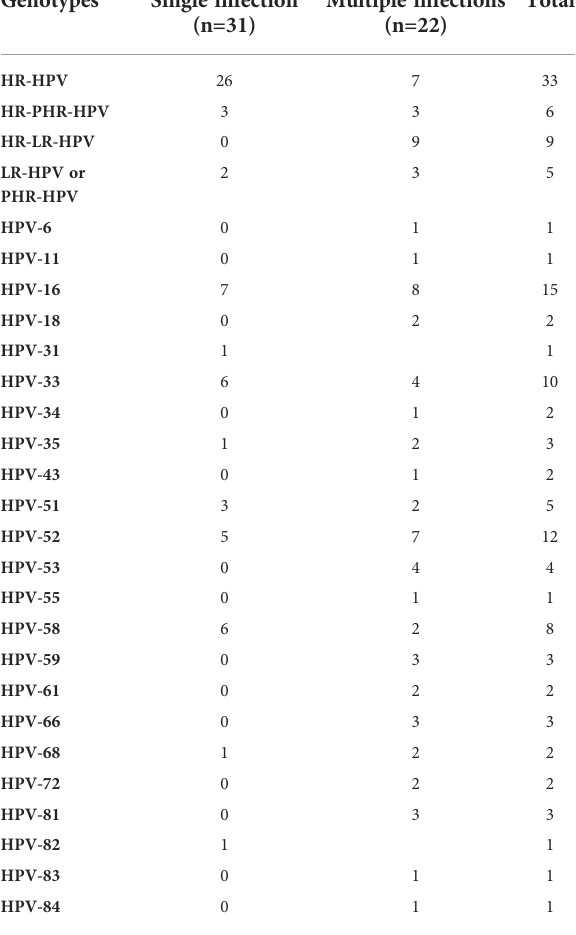
TABLE 1 Different HPV distribution among single infection and multiple infections.